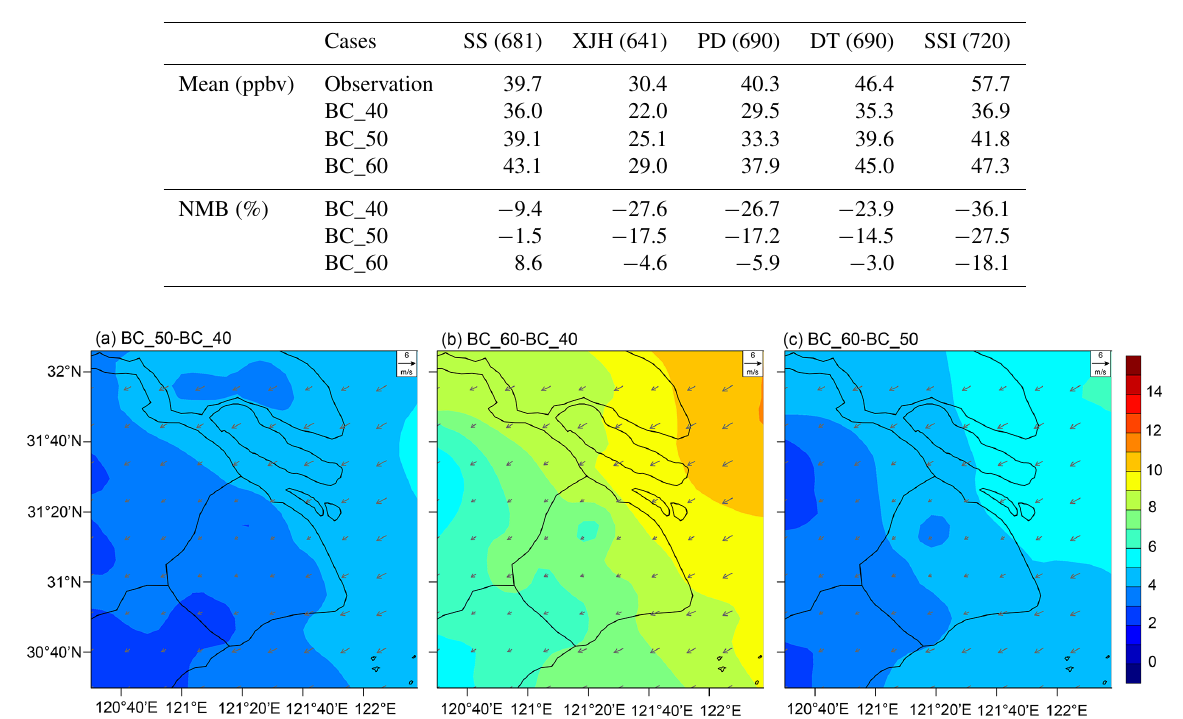
Table 4. Statistical results of the comparisons between the simulated and observed surface O 3 concentrations at the Sheshan (SS), Xujiahui (XJH), Pudong (PD), DT (Dongtan) and Sheshan Island (SSI) sites during September 2014. The calculated O 3 levels are obtained from BC_40, BC_50 and BC_60 simulations, respectively. Values of the average surface O 3 concentrations (Mean) and normalized mean bias (cid:80) n − O i ) i = 1 (P i (NMB) are displayed. The NMB is defined as NMB = , where P i and O i are predicted and observed ozone mixing ratios for (cid:80) n i = 1 O i sample i , n is the number of total samples (numbers in parentheses).